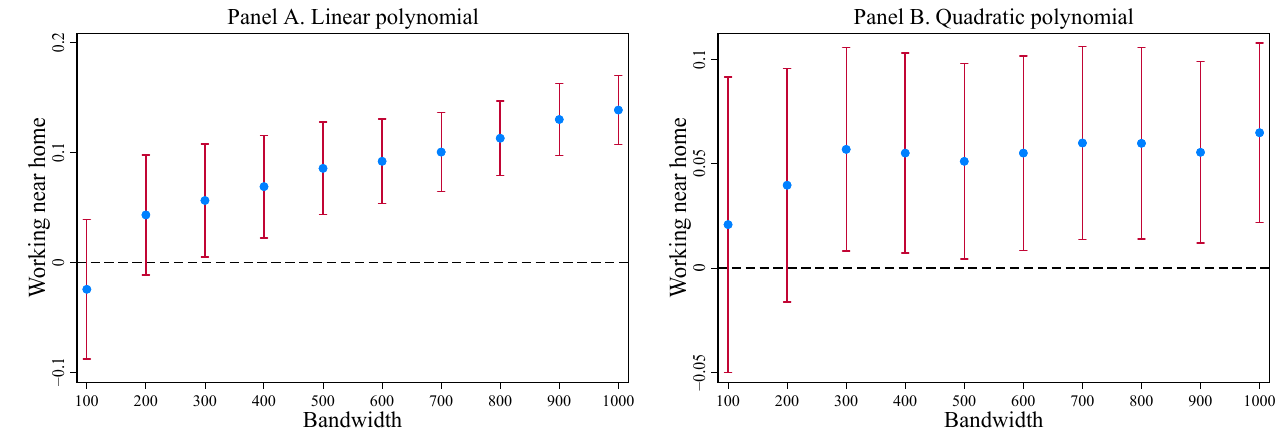
Figure A5. Robustness to alternative bandwidths for the impact of the Huai River Policy on work.